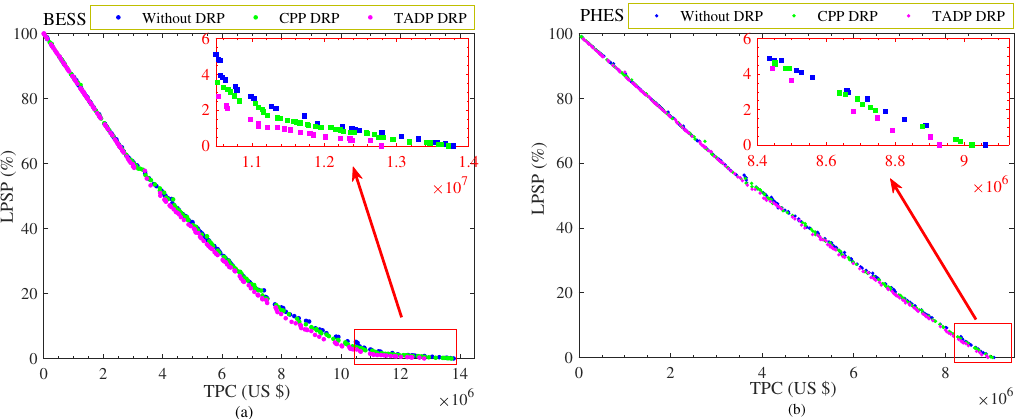
Figure 9. ( a , b ) shows the Pareto front plots comparison for BESS and PHES-based microgrid design respectively, based on the DRP flexibility options.